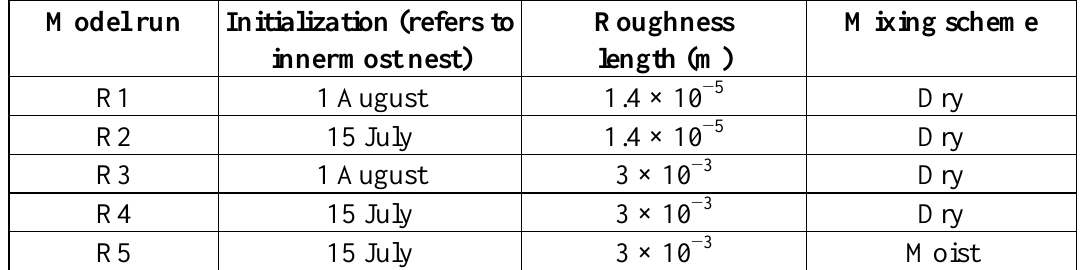
Table 1. Summary of ensemble members outlining the differences between the